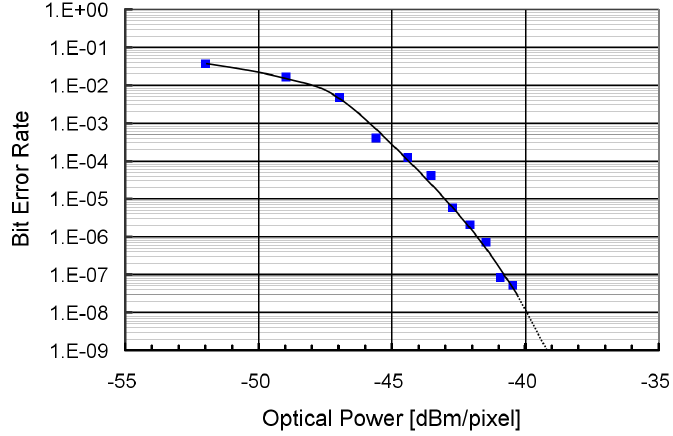
Figure 23. Bit Error Rate.